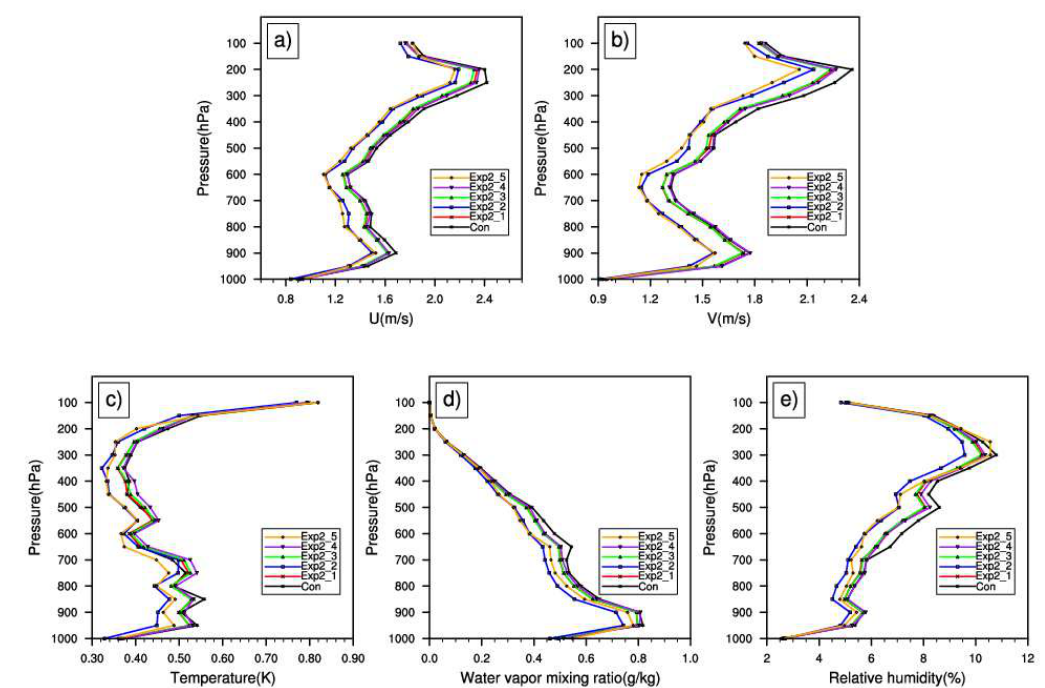
Figure 10. Vertical profiles of RMSEs in ( a ) u winds (unit: m s −1 ) ( b ) v winds (unit: m s −1 ) ( c ) temperature (unit: K) ( d ) water vapor mixing ratio (unit: g/kg) ( e ) relative humidity (unit: %) from the Con, Exp2_1, Exp2_2, Exp2_3, Exp2_4, and Exp2_5. Results are valid at 00:00 UTC on 29 June 2009 and are calculated for the whole horizontal domain.